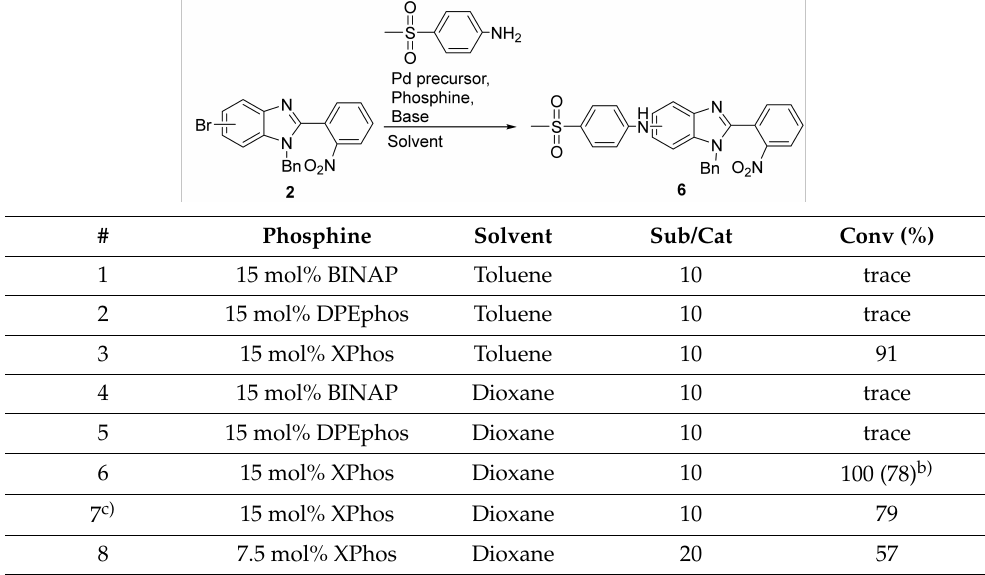
Table 3. Optimization of the reaction conditions for the Buchwald-Hartwig coupling of